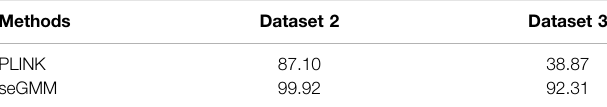
TABLE 2 | Gender prediction accuracy of different methods for samples in datasets 2 and